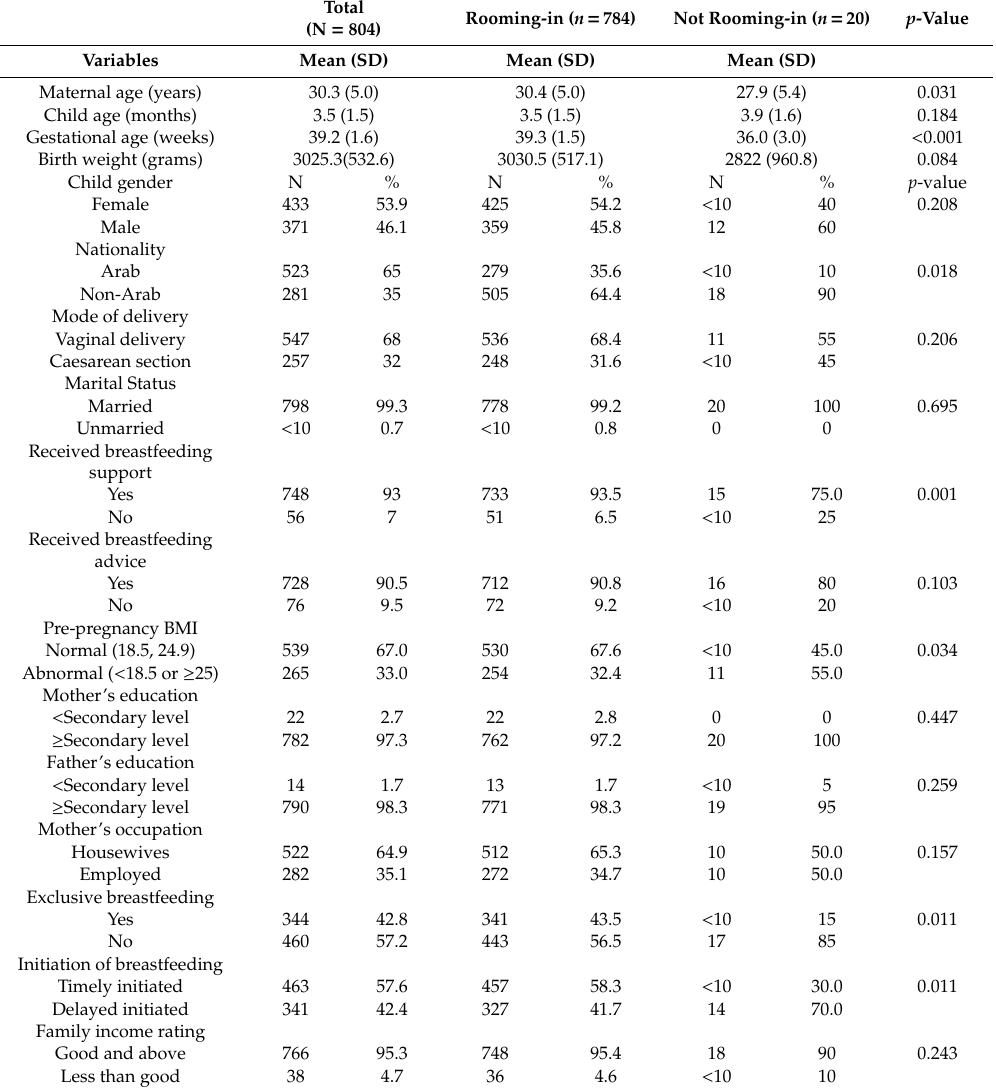
Table 1. Socio-demographic characteristics of the studied participants in Abu Dhabi, UAE.